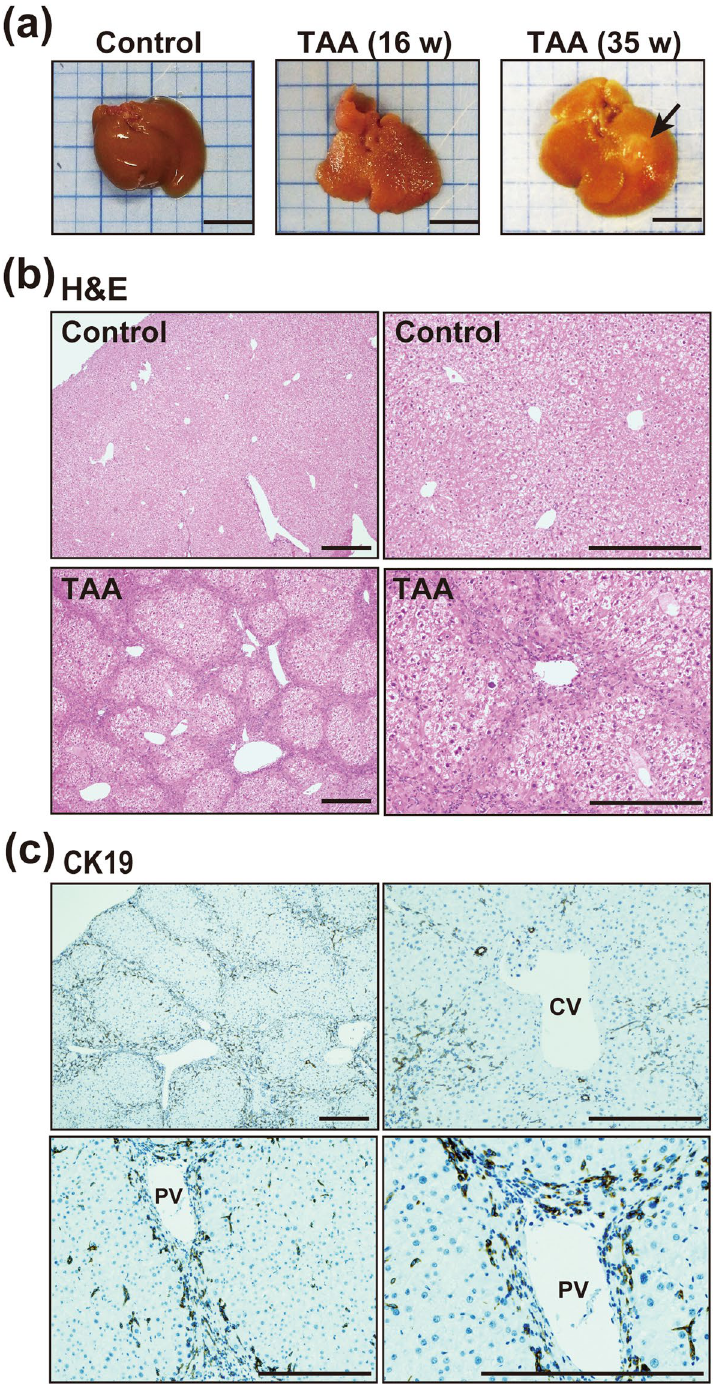
Figure 7. TAA-induced liver injury may promote conversion of hepatocytes to biliary lineage cells. ( a ) Macroscopic appearance of the liver of mice administered TAA for 16 and 35 weeks. Administration of TAA induced prominent inflammation in the liver by16 weeks and development of liver tumors (arrow) by 35 weeks. Scale bars: 10 mm. ( b ) H&E staining of the liver of control mice and mice administered TAA for 16 weeks. Administration of TAA induced prominent inflammation and fibrosis around Glisson’s capsule in the liver by 16 weeks and development of liver tumors by 35 weeks. Scale bars: 300 μ m. ( c ) Immunohistochemical staining of CK19 in the liver of control mice and mice administered TAA for 16 weeks. The cholangiocyte marker CK19 was strongly expressed in cells around portal veins (PV) in the liver, whereas cells around central veins (CV) showed no expression of CK19. Scale bars: 300 μ